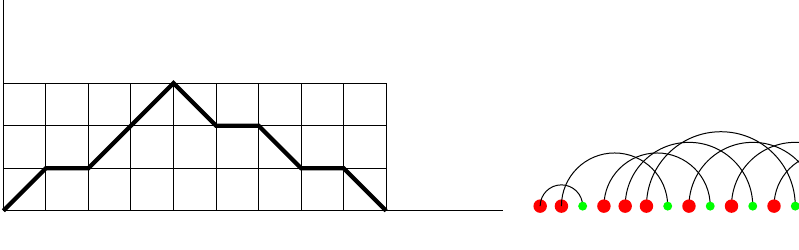
Fig. 4: The Motzkin path UHUUDHDHD and its corresponding involution σ = 3719(11)(13)2(14)4(16)5(17)68(19)(10)(12)(20)(15)(18)